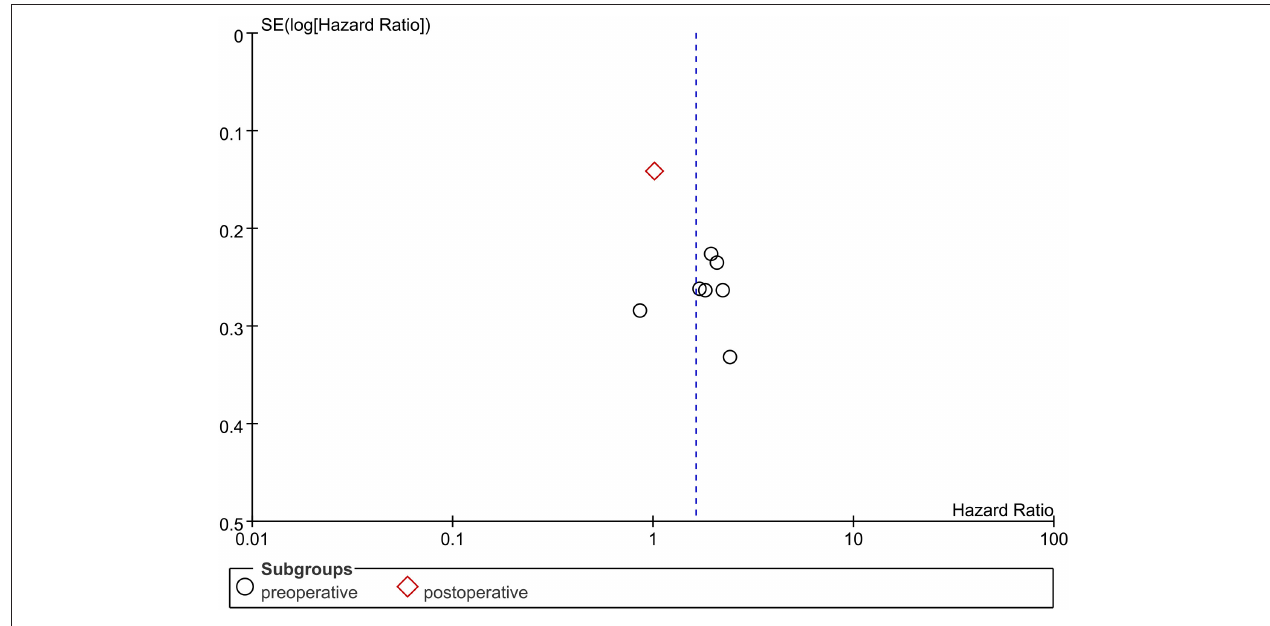
FIGURE 4 | Funnel plot of publication bias of NLR in GBM patients. No significant publication bias was found in the present